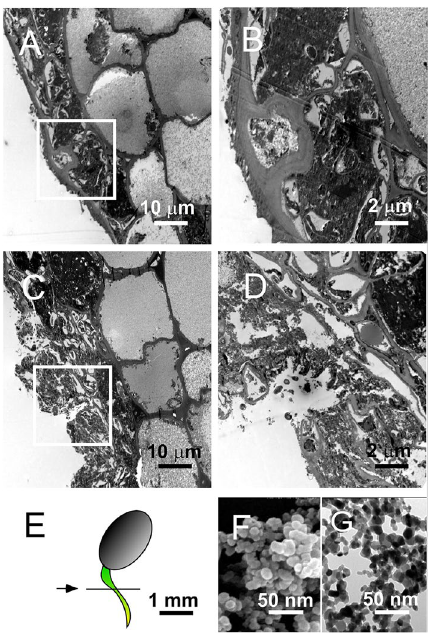
Figure 10. Electron microscopy analysis of high level TiO 2 NP-induced tissue damages on seedlings of Amaranthus mangostanus. TEM images of root tissue samples of seedlings Amaranthus mangostanus in 0 ( A,B ) and 1 mg/cm 2 TiO 2 groups ( C,D ), at low ( A,C ) and high ( B,D ) magnifications are shown. The white square highlighted areas in ( A,C ) are shown at a higher magnification in ( B,D ), respectively. The section position in ( A–D ) is indicated in ( E ). The SEM and TEM images of TiO 2 NPs are also shown in ( F ) and ( G ), respectively. Scale bars: ( A,C ) 10 µm; ( B,D ) 2 µm; ( E ) 1 mm; ( F,G ) 50